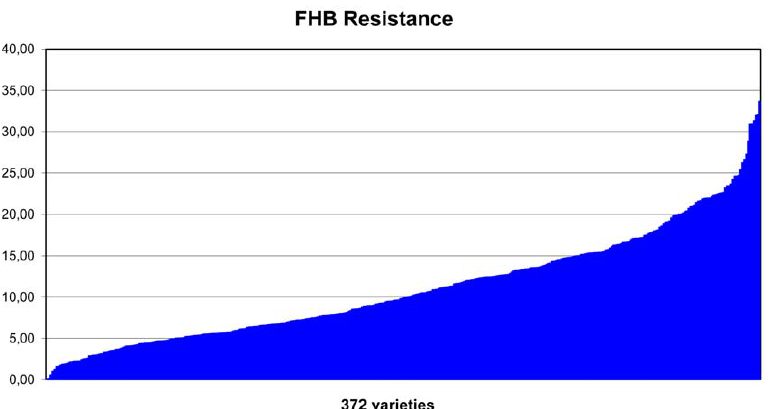
Figure 1. Phenotypic distribution of FHB score BLUEs in 372 varieties. The BLUEs of the FHB score (FHB incidence 6 FHB severity) were based on resistance tests in four environments. A low FHB score indicates high resistance.